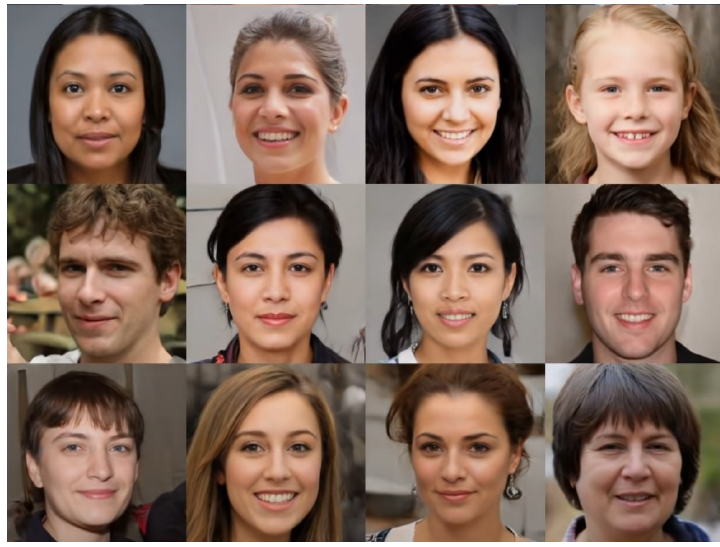
Figure 1. High-quality face photos generated by GAN